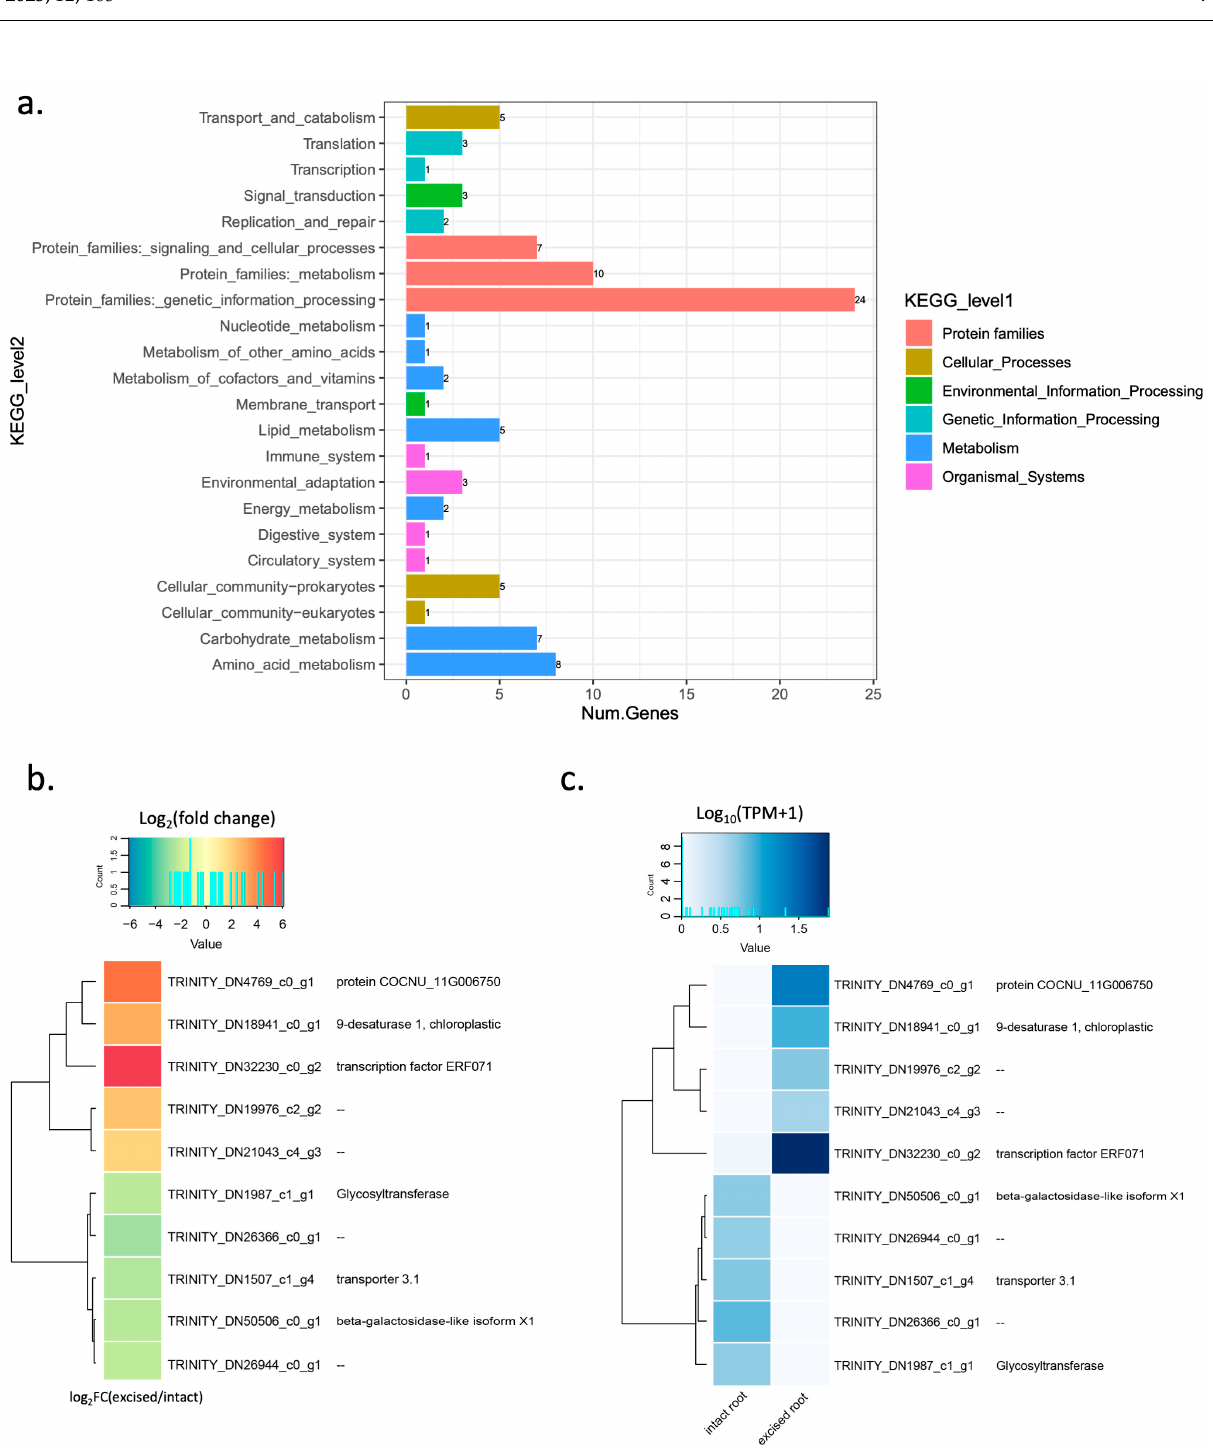
Figure 4. KEGG pathway enrichment of DE genes and the top twenty most highly expressed genes in comparison between intact and excised roots. ( a ) The KEGG pathways were summarized in six main categories. The y -axis indicated the name of the KEGG metabolic pathways. The x -axis indicated the percentage of the number of genes annotated under that pathway. ( b ) Hierarchical clustering heatmap of log 2 (fold change) of the twenty most highly expressed transcripts. ( c ) Hierarchical clustering heatmap of log 10 TPM of the twenty most highly expressed